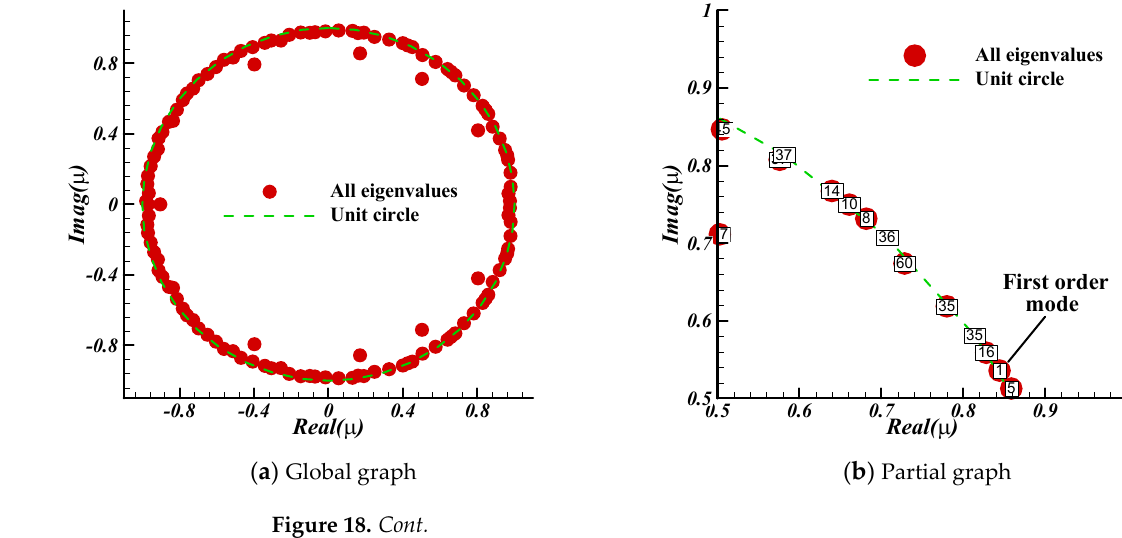
Figure 17. The energy distribution of the different modes.